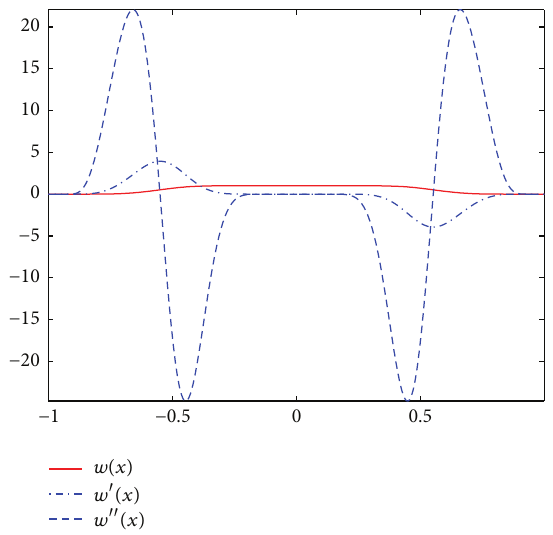
Figure 4: We show 𝑤(𝑥) = sin ((𝜋/2)(𝑒 −𝑐/𝑥 /(𝑒 −𝑐/𝑥 + 𝑒 −𝑐/(1−𝑥) ))) , 𝑑𝑤(𝑥)/𝑑𝑥 , and 𝑑 2 𝑤(𝑥)/𝑑𝑥 2 where 𝑐 = 1.57